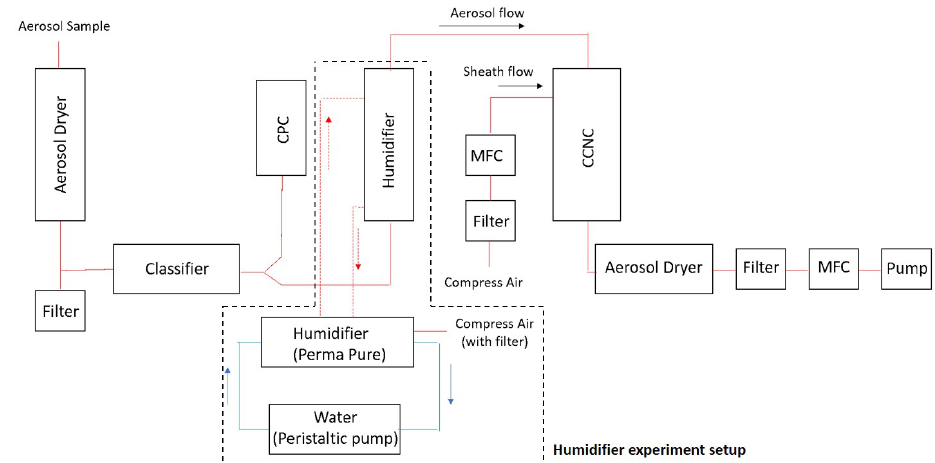
Figure 2. Schematic plot of a broad scanning supersaturation cloud condensation nuclei counter (BS2-CCN) system. An additional setup marked with a dashed line is for a humidifier